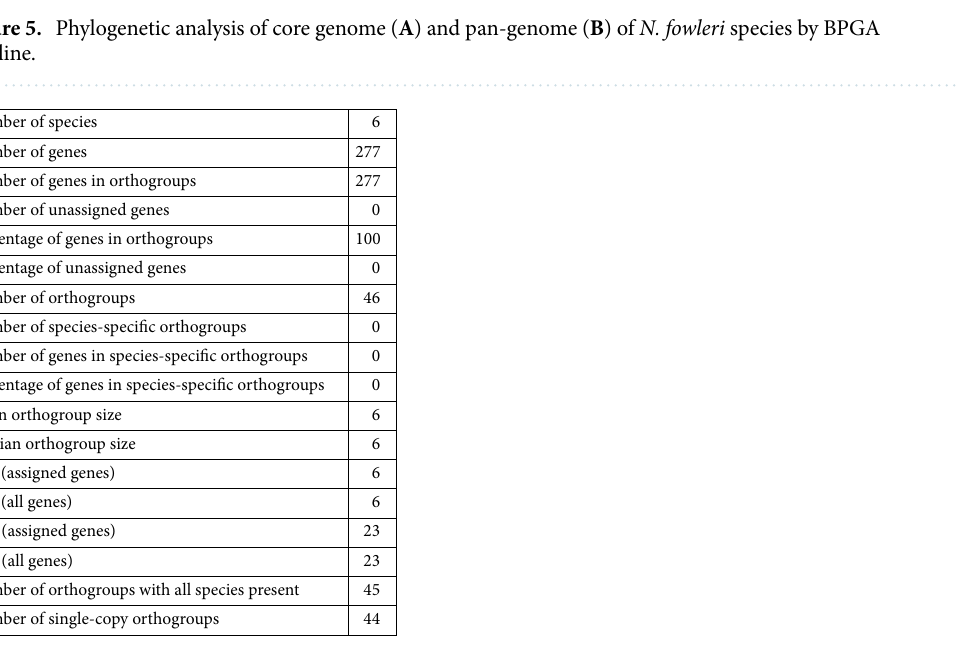
Table 3. General statistics about orthogroups sizes and proportion of genes assigned to orthogroups.